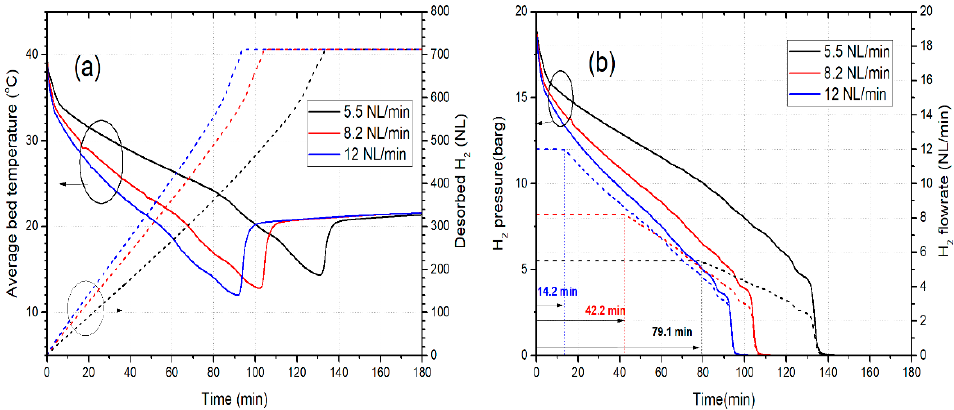
Figure 4. Dynamic behavior of hydrogen desorption from MHR-PCM under constant hydrogen velocity (flowrate): ( a ) average bed temperature and H 2 volume desorbed, ( b ) H 2 gauge pressure and flowrate.